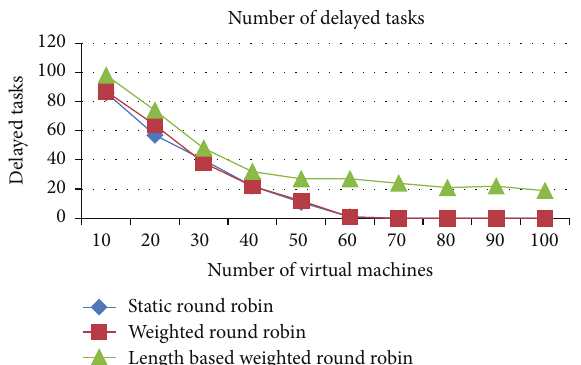
Figure 15: Number of delayed tasks (space shared).